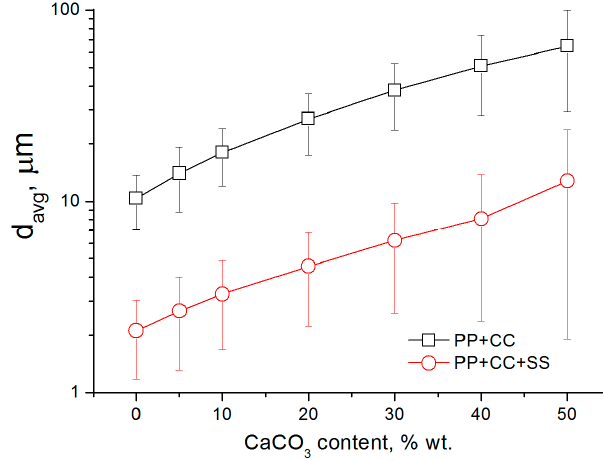
Figure 4. E ff ect of CaCO 3 content on the average fiber Figure 4. Effect of CaCO 3 content on the average fiber diameters.